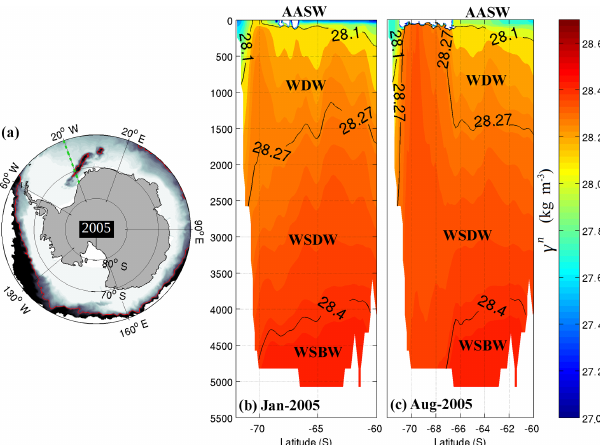
Figure 12. (a) A map of the sea ice concentration of SoSE in Au- gust 2005 showing the polynya. The transect used is marked by the dashed green line. The black areas are those with 0% sea ice con- centration. The red line marks the 30% sea ice concentration mar- gin, as the border of the polynya. (b) and (c) : the neutral density contours from a 20 ◦ W vertical section in January and August, re- spectively. The neutral density lines of 28.1, 28.27 and 28.4kgm − 3 separate the AASW/WDW, WDW/WSDW and WSDW/WSBW, re-